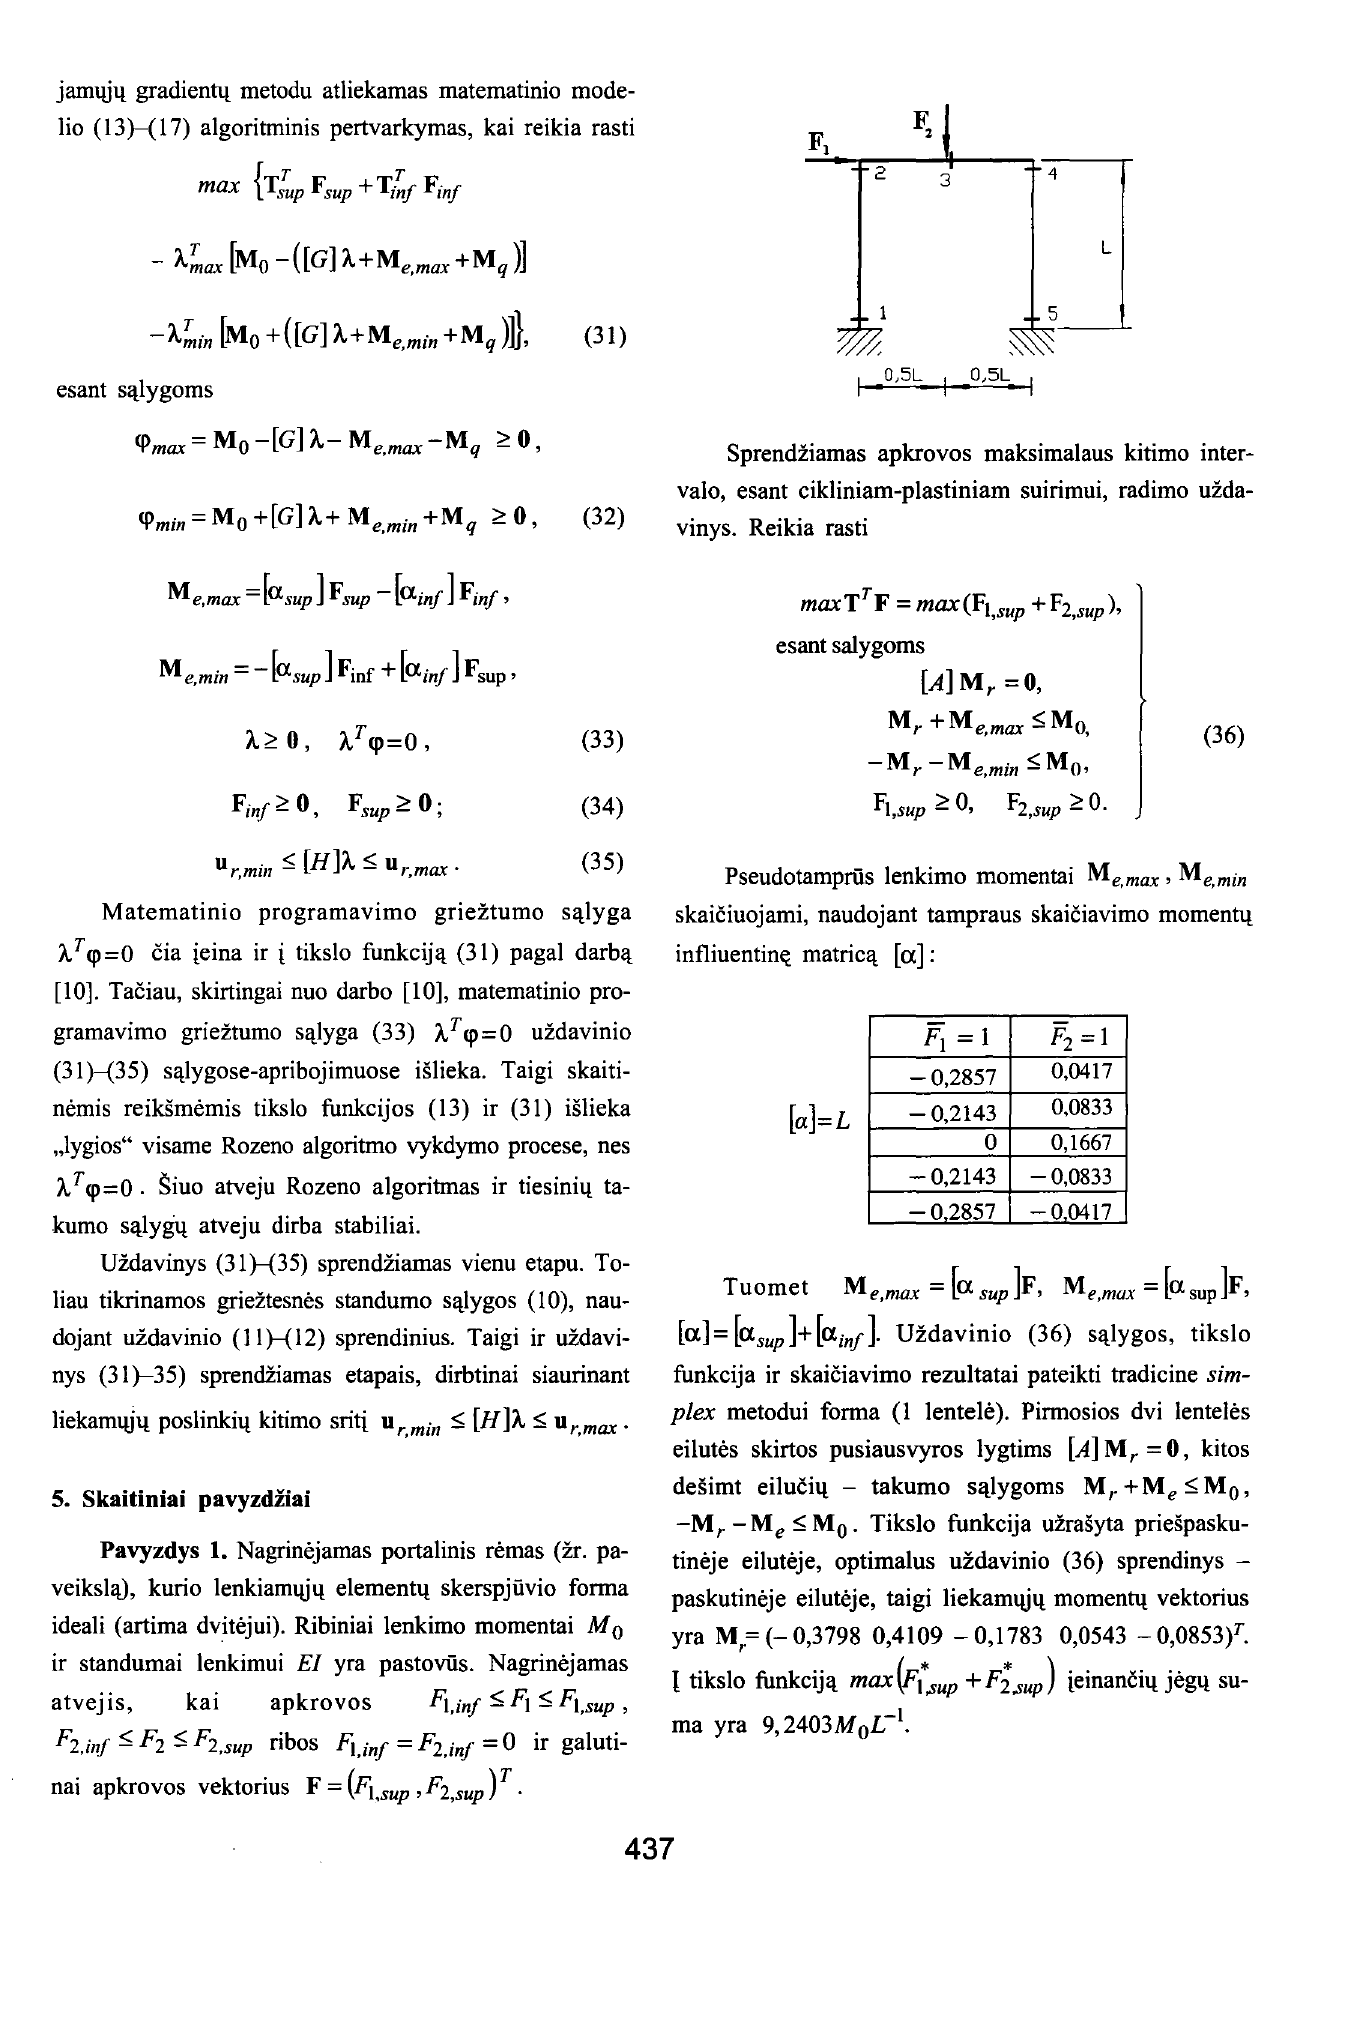
Pavyzdys l. Nagrinejamas porta1inis remas (zr. pa